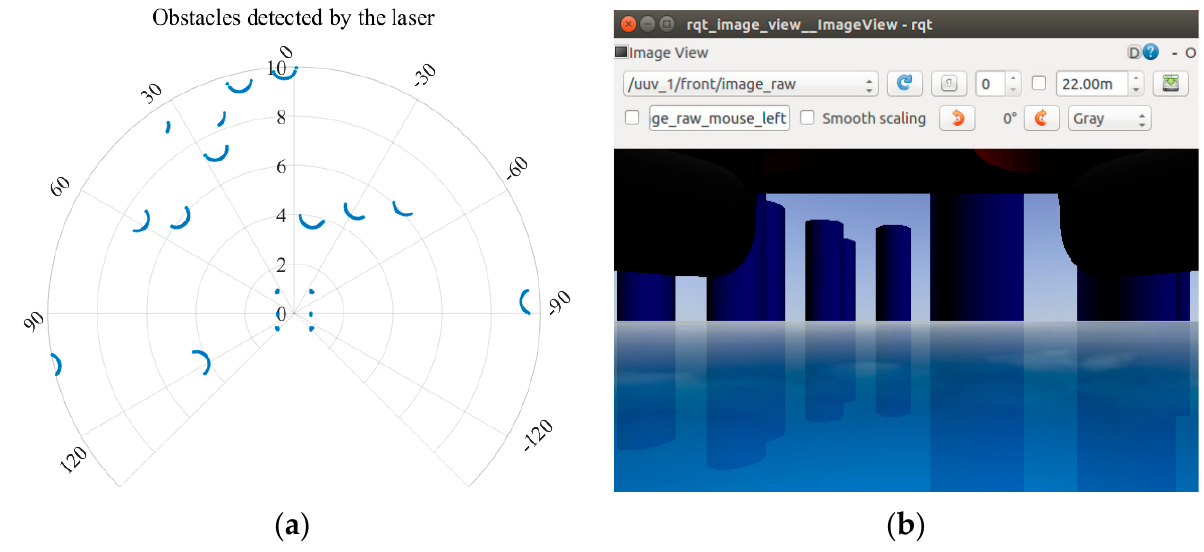
Figure 4. Sensor images of laser and underwater camera. ( a ) The obstacles detected by laser. ( b ) Environmental information captured by underwater camera.